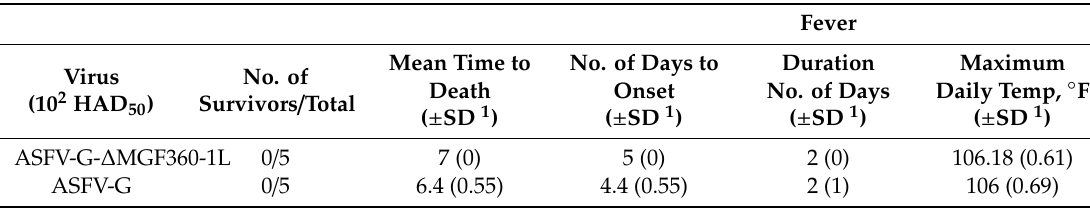
Table 1. Swine survival and fever response following infection with ASFV-G- ∆ MGF360-1L and parental ASFV-G.